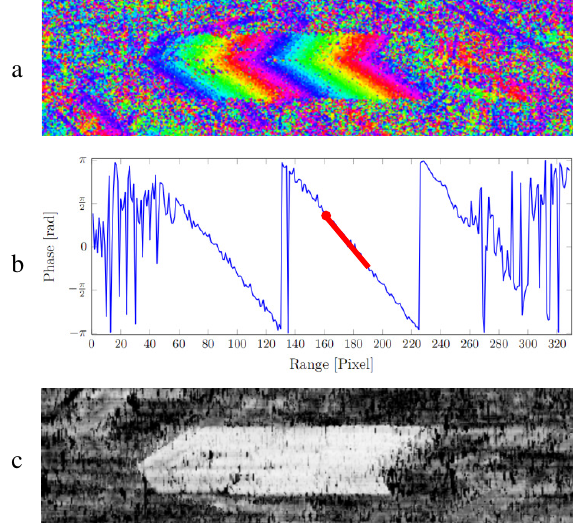
Figure 5: Detector of phase ramps – InSAR phase signature (a), phase profile overlaid with synthetic ramp (b, red), result of detector